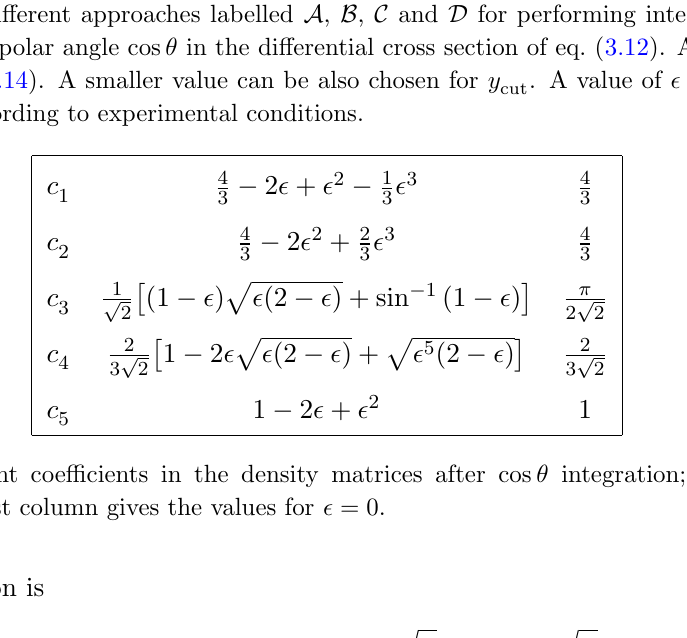
, , and for performing integration over the A B C D . A value of (cid:15) (0 cut